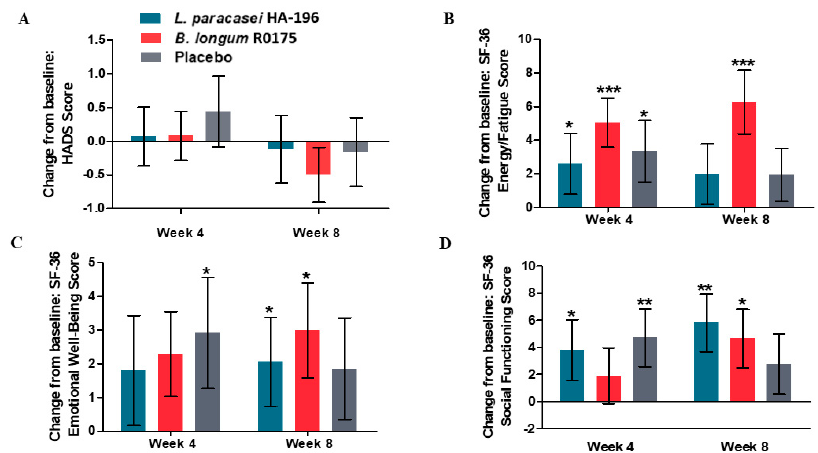
Figure 8. Effect of Lactobacillus paracasei HA-196 and Bifidobacterium longum R0175 on psychological symptoms in participants with IBS from baseline to week 4 and week 8 ( A ) Mean change from baseline in HADS score, ( B ) Mean change from baseline in SF-36 energy levels, ( C ) Mean change from baseline in SF-36 emotional well-being, and ( D ) Mean change from baseline in SF-36 social functioning. L. paracasei group n = 84, B. longum group n = 86, placebo group n = 81; data represented as mean ± SD; * p <